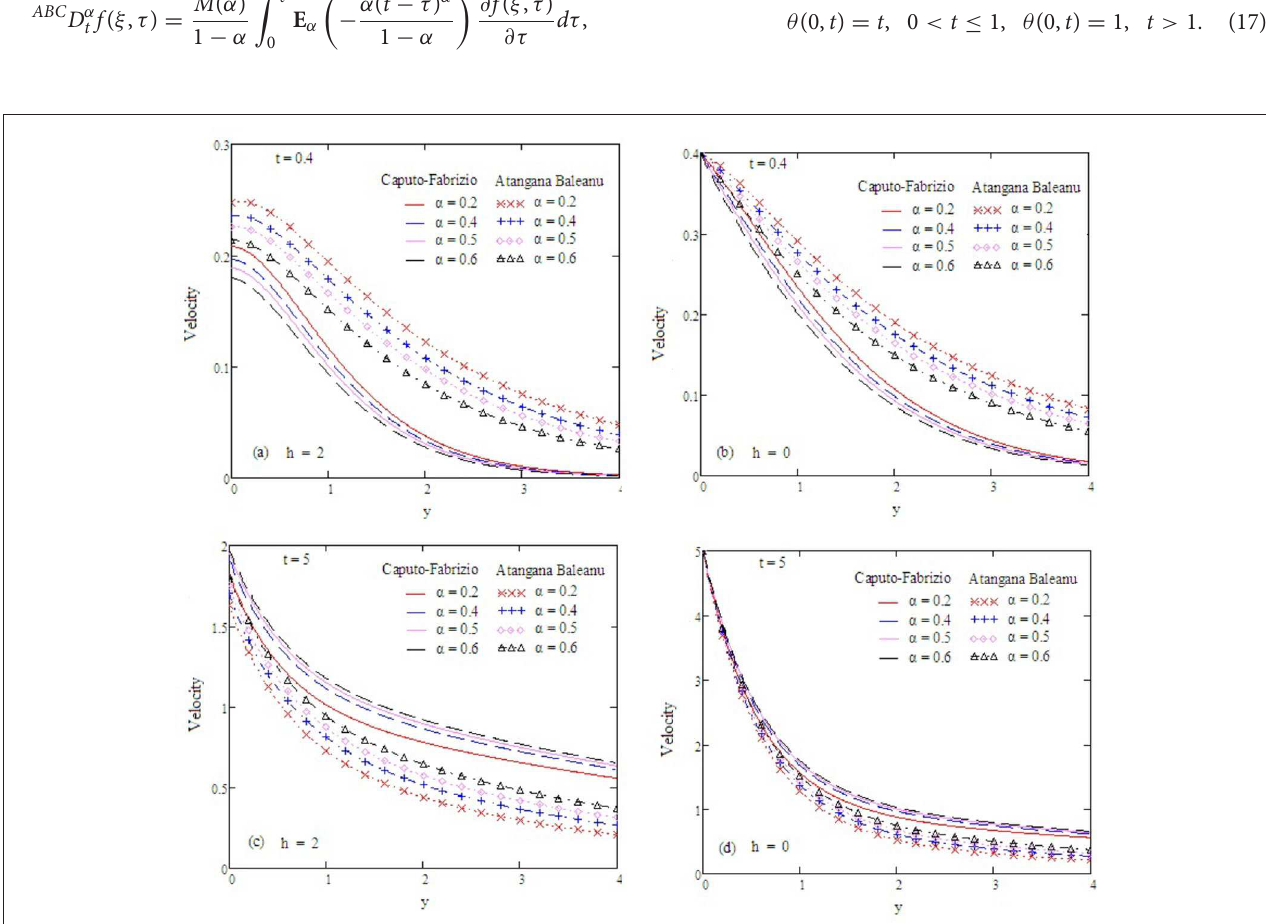
1.5, G r 2, P reff 0.1, G m 0.75, M 0.9, and S c = = = = =